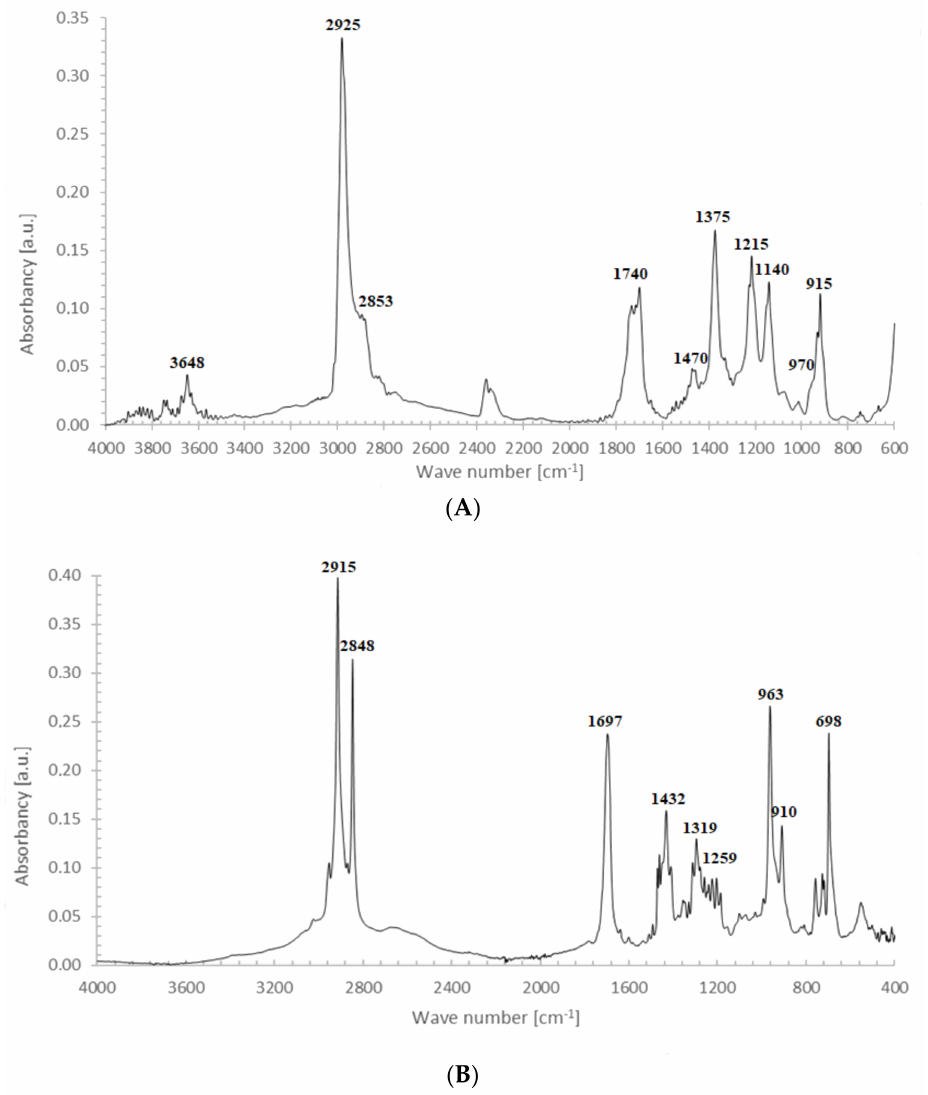
Figure 3. FTIR spectrum of SBR crosslinked with CPO oligomer: ( A ) CPO; and ( B )